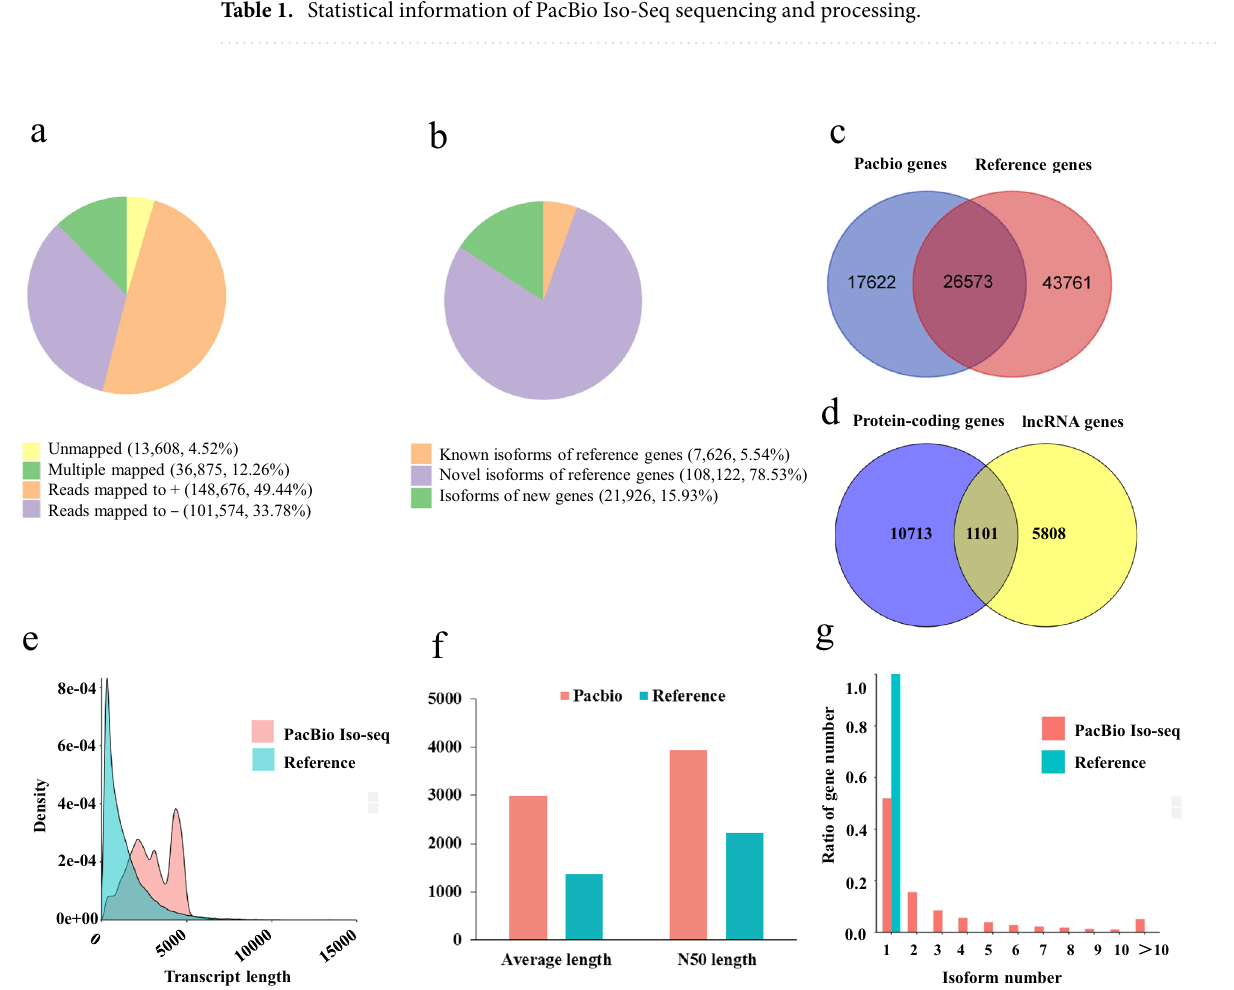
Figure 2. GMAP mapping result and the comparison of goldfish transcript isoforms between the PacBio Iso-Seq and reference genome annotation. ( a ) Statistics of the consensus sequences mapped onto the reference genome. ( b ) Classification of transcript isoforms corresponding to the reference genome. ( c ) The comparison of gene numbers between Pacbio Iso-Seq and the reference genome annotation. ( d ) Classifications of novel gene loci identified in PacBio Iso-Seq. ( e ) The comparison of transcript length distribution between Pacbio Iso-Seq and the reference genome annotation. ( f ) Comparisons of the average length and N50 length of transcripts between Pacbio Iso-Seq and the reference genome annotation. ( g ) The comparison of transcript isoform number between Pacbio Iso-Seq and the reference genome annotation. The figures were constructed in ggplot2 (https :// ggplo t2.tidyv